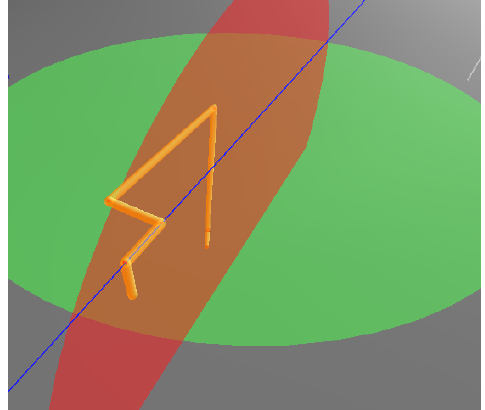
Figure 8: The green planes is Π c ⊥ and the red plane is Π and the blue line is L c (cid:107)